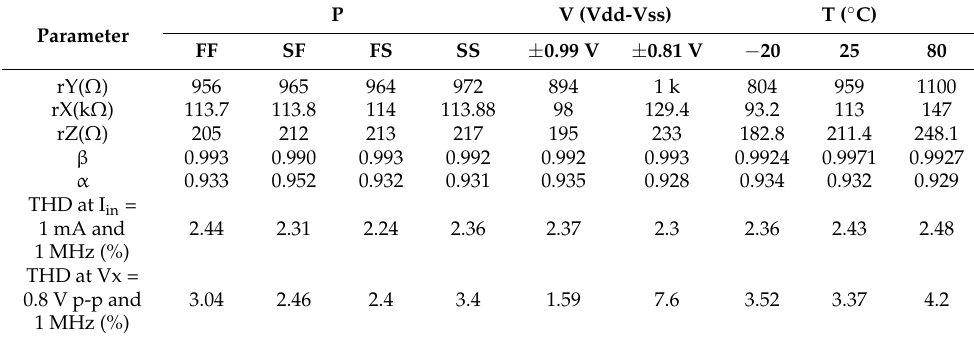
Table 5. PVT Simulation results.